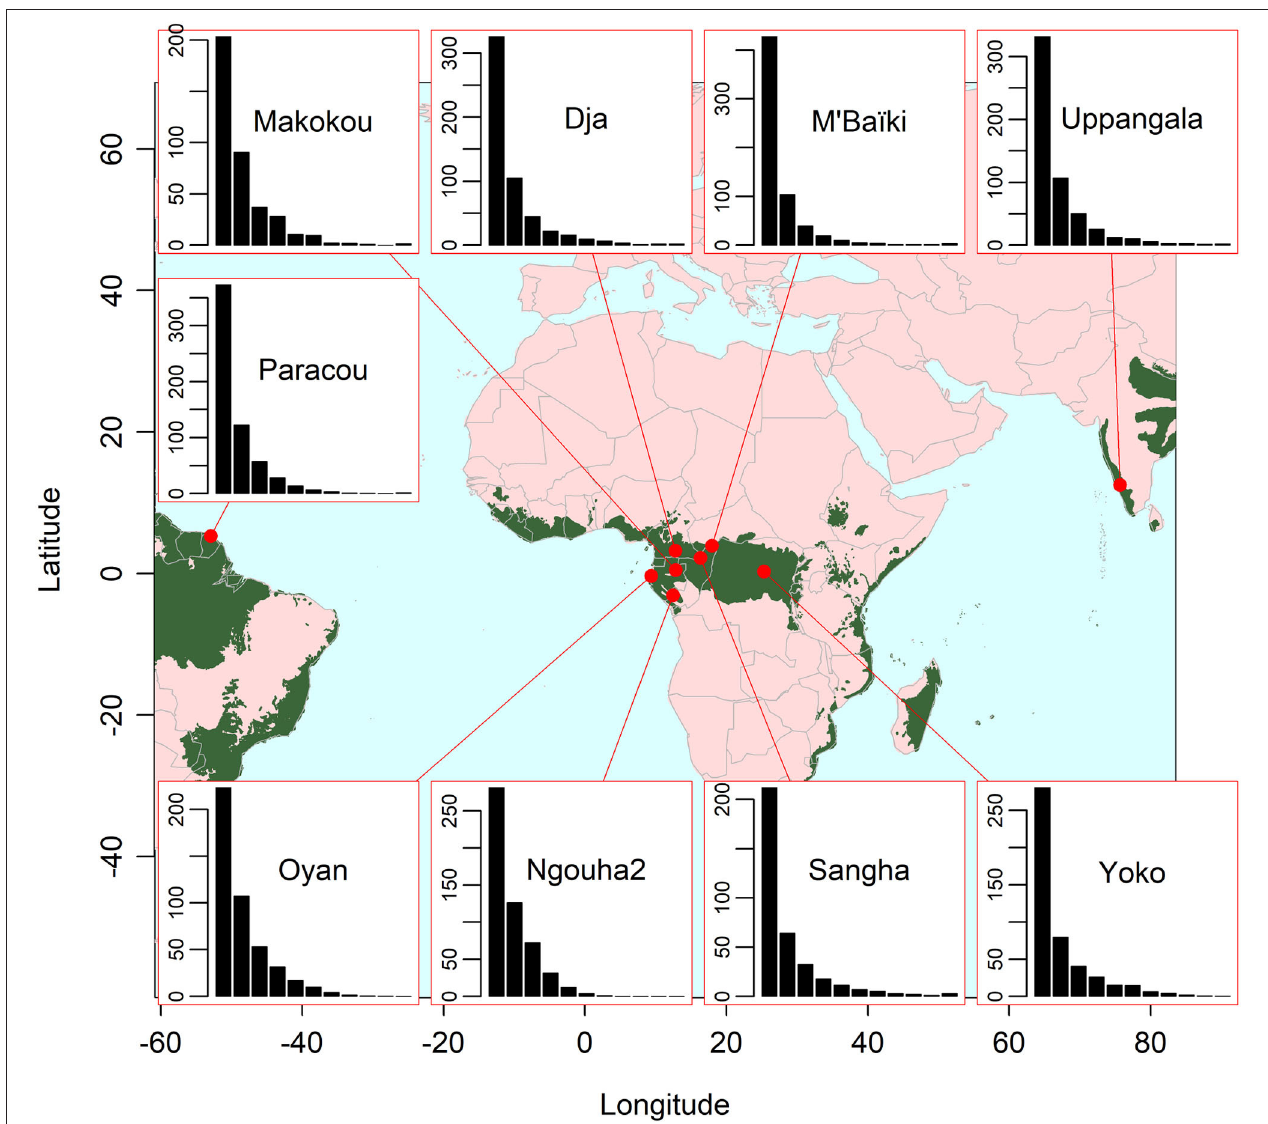
FIGURE 2 | Location of the nine study sites and distribution of the diameter at breast height (dbh) at each site (inset plots). The green area represents the biome of tropical and subtropical moist broadleaf forests as delimited by Dinerstein et al. (2017). In the insets, the eleven bars correspond to the eleven diameter classes 10–20 cm, 20–30 cm, …, 100–110 cm, and ≥ 110 cm, while the y-axis gives the density of trees per